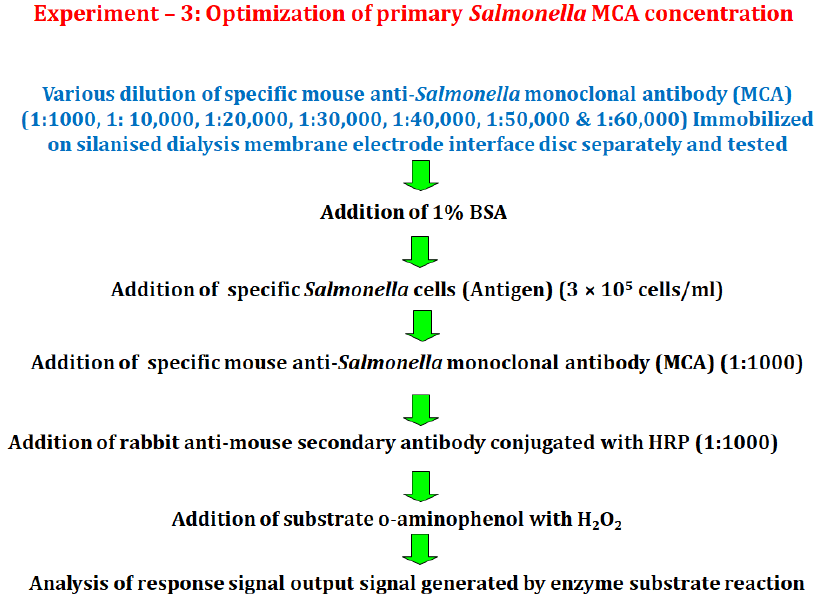
Figure 4. Schematic diagram showing optimization of mouse anti- Salmonella monoclonal antibody (MCA) concentration for the detection of Salmonella cells.